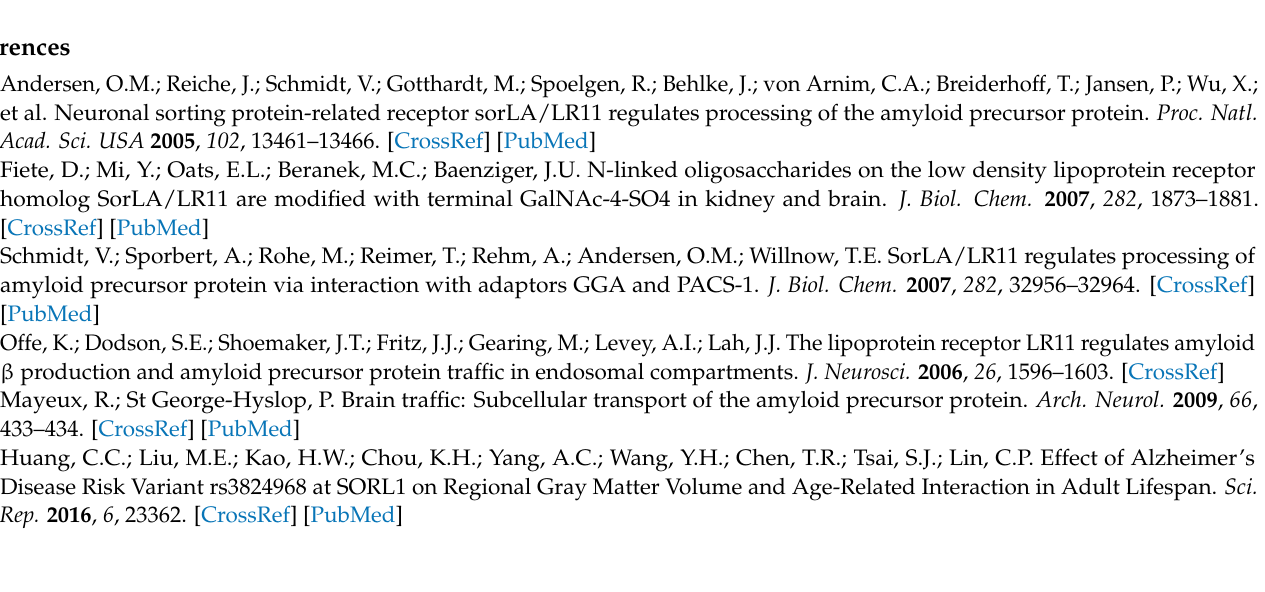
Table S1: Single Nucleotide Polymorphisms (SNPs) used in this study; Table S2: Genotypic distri- bution in different populations; Table S3: Allelic Distributions in different populations; Table S4: Haplotype analysis; Table S5: Three-loci haplotype frequency in AD and